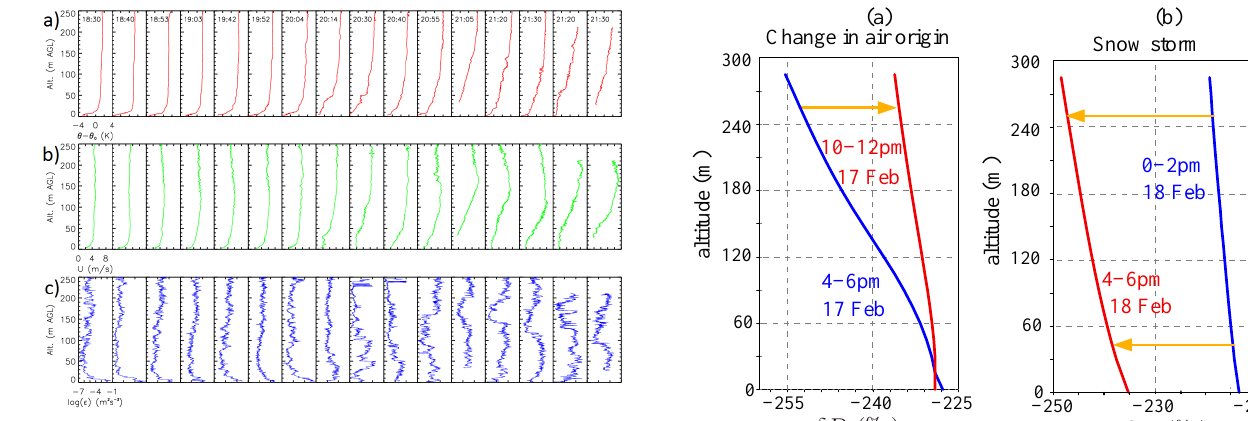
Fig. 7. Composite profiles from a high speed sensor on the tethered lift system during the night of 17 February 2010 during the forma- tion of a low level jet. (a) The difference between potential temper- ature and potential temperature at the surface (K), (b) wind speed (ms − 1 ) and (c) log of turbulence dissipation rate (m 2 s − 2 ) . Panels show a sequence approximately 10–30 min apart as indicated in (a) between 06:30 p.m. and 09:30 p.m. local time.